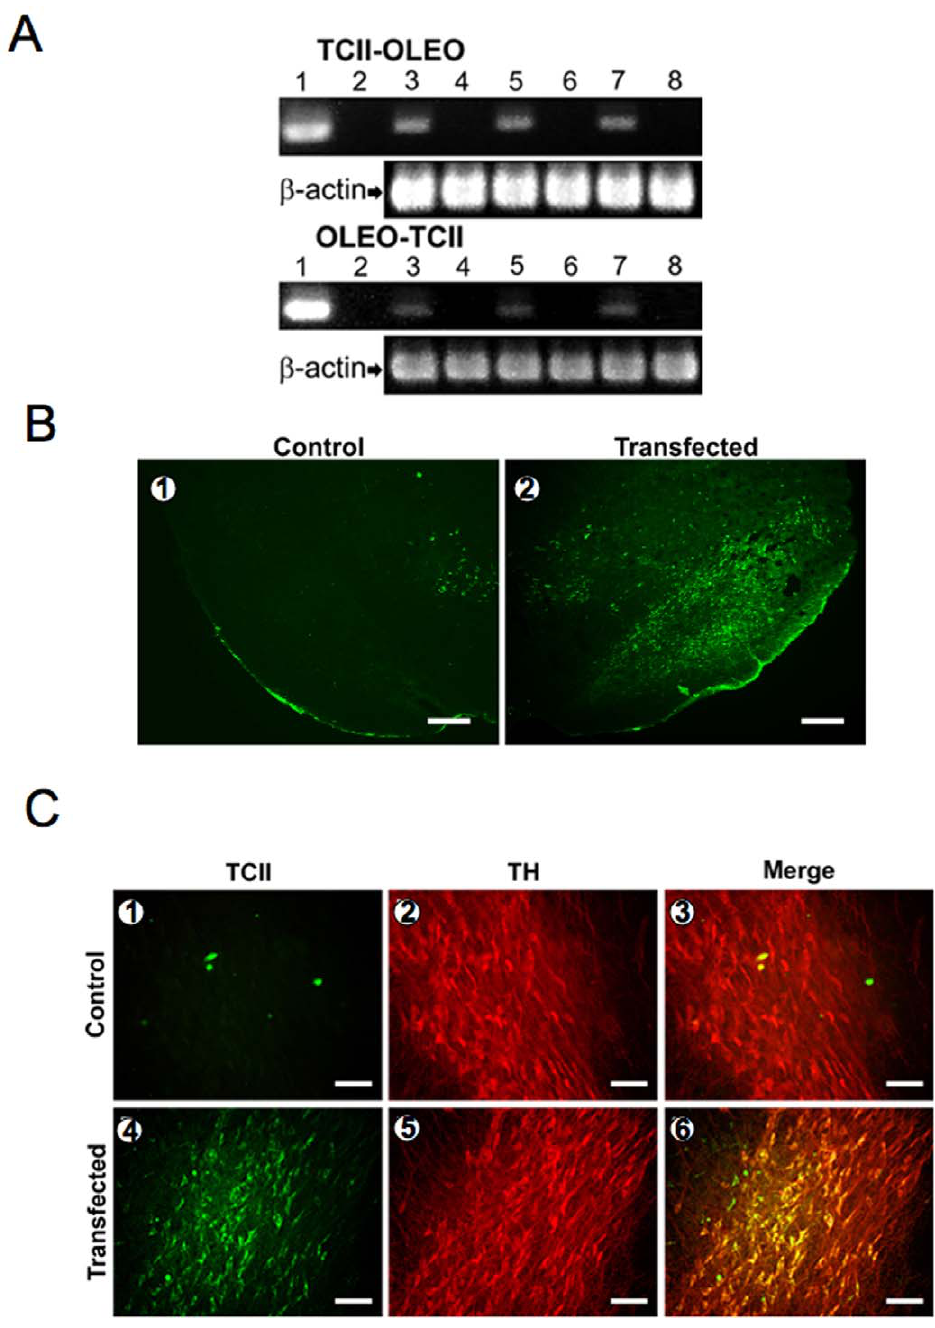
Figure 4. Expression of transcobalamin II/oleosin (TCII/OLEO) chimeric proteins in rats 60 days after transfection with the NTS- polyplex. A:RT-PCRfromtheplasmid transcriptsinthe substantia nigra of rats. A groupof rats (n=3) was transfectedwith theplasmid pCMV-TCII-OLEO and another (n=3) with the plasmid pCMV-OLEO-TCII. RT-PCR amplified a fragment of 380 bp for TCII-OLEO, a fragment of 394 for OLEO-TCII, and a fragment of 349 for b -actin, the internal control. Lane 1 corresponds to the amplified fragment from the plasmid (positive control). Lane 2 is a PCR in the absence of plasmid or cDNA (negativecontrol).Theamplifiedproduct from thetransfectedsubstantianigra of each ratcorrespondsto thelanes 3,5, and 7, and the lanes 4, 6, and 8 show the RT-PCR outcome from the non-transfected side. B: GFP immunofluorescence in the rat substantia nigra transfected with pCMV-GFP-TCII-OLEO. The pCMV-GFP-TCII-OLEO encodes for the fusion protein green fluorescent protein-transcobalamin-oleosin (GFP-TCII-OLEO). The immunofluorescence was done with a mouse monoclonal antibody to GFP and a donkey antimouse IgG fluorescein labeled. Representative micrographs of coronal section of control substantia nigra (1) and transfected substantia nigra (2) of the same rat are presented. Calibration bars=100 m m. C: Double immunofluorescence against TCII and tyrosine hydroxylase (TH) in the substantia nigra of rats. The neurons were transfected with NTS-polyplex with pCMV-TCII-OLEO coding for transcobalamin-oleosin (TCII-OLEO). Slices from mesencephalon (40 m m) were immunostained at 7-day after transfection. The primary antibodies were a goat polyclonal anti-TCII and a mouse monoclonal anti-TH. The secondary antibodies were a donkey antigoat IgG fluorescein labeled and a donkey antimouse IgG rhodamine labeled. Representative micrographs of coronal section of control substantia nigra (1–3) and transfected substantia nigra (4–6) of the same rat are presented. Calibration bars=50 m m.